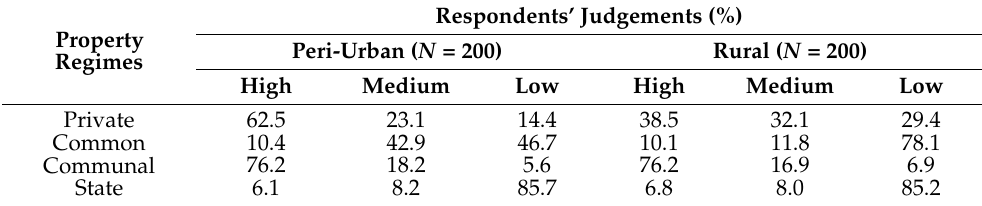
Table 4. Land tenure disputes on different property regime types (multiple